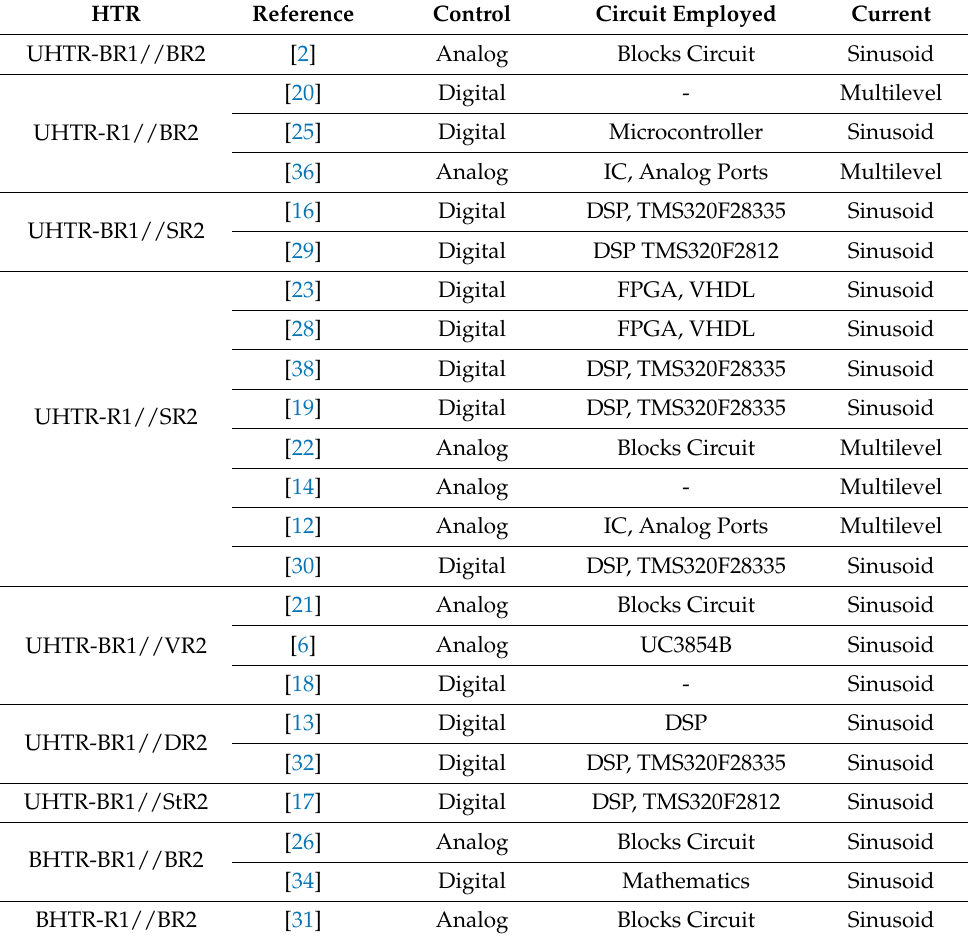
Table 6. HTR type of control applied in